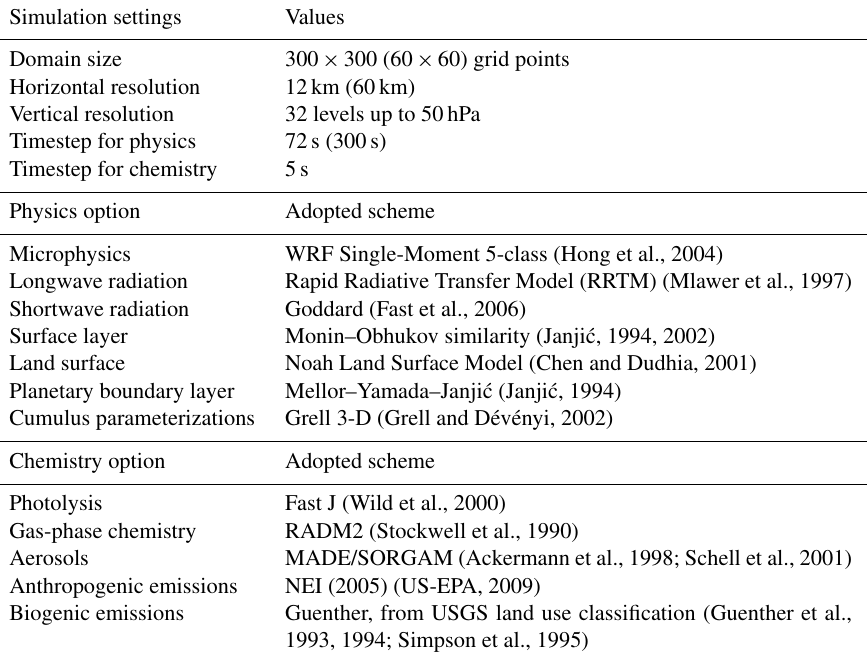
Table 1. Physical and chemical schemes adopted in the WRF-Chem simulations presented